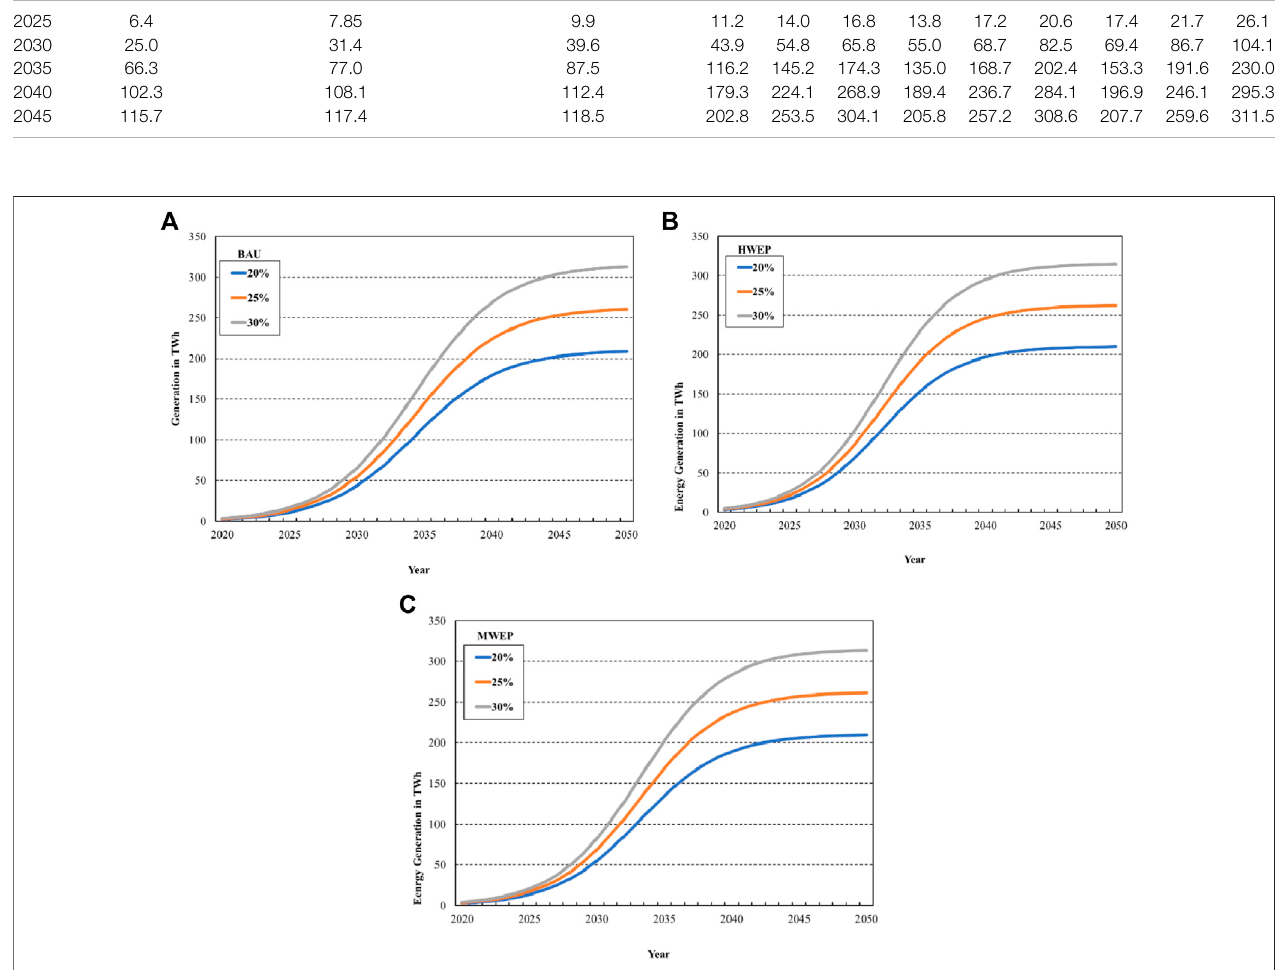
FIGURE 8 | Projected cumulative electricity generation from wind power under (A) BAU scenario, (B) HWEP scenario, and (C) MWEP scenario.